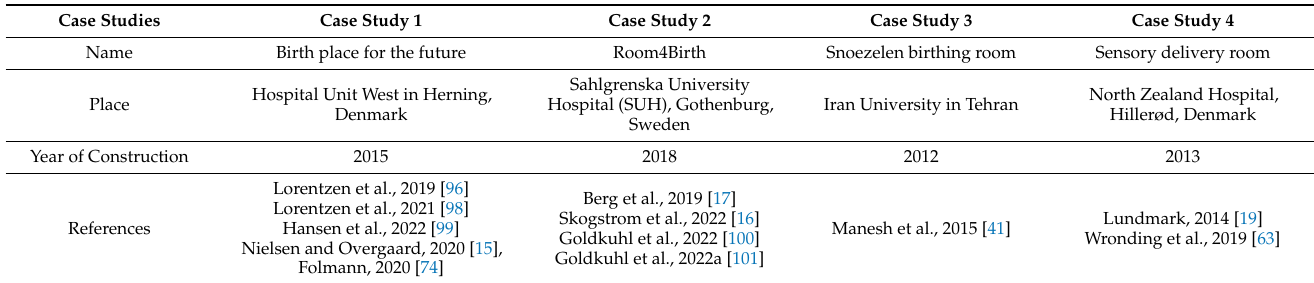
Table 1. List of case